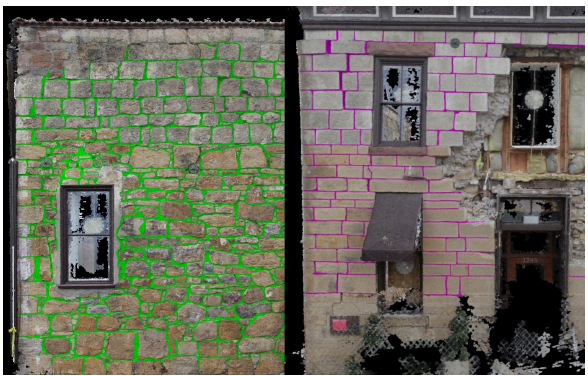
Figure 3. Ground truth tagging of the